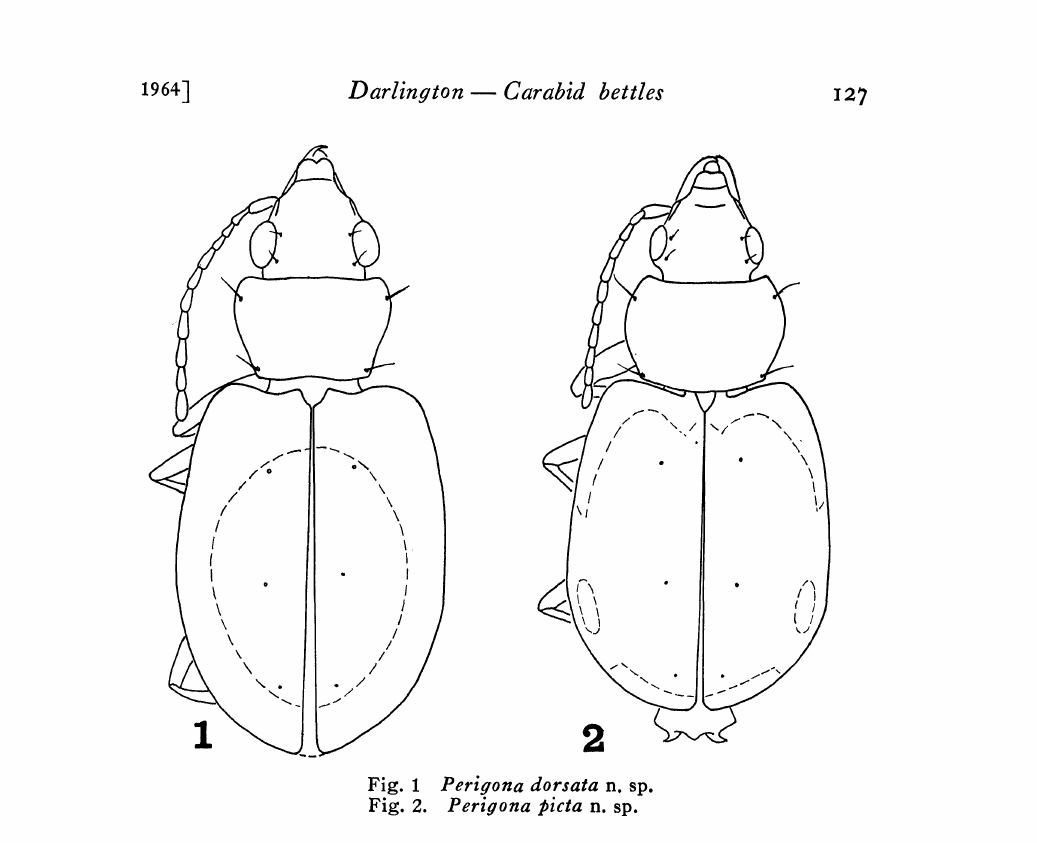
Fig. Periyona dorsata n. sp. Fig. 2. Perigona #icta n. sp. Cape York, by washing thick accumulations of leaves and bird drop- pings from under a tree where a colony of birds had nest.ed, and I have specimens from Lankelly Creek on the NIcIlwraith Range east of Coen half way up the ’Cape York Peninsula, and from Cairns, Kuranda, and Longlands Gap on the Atherton Tableland, North Queensland. Sloane’s type of australica was from Mackay, Queens- land. The species is to be expected anywhere in the warmer part of Australia.